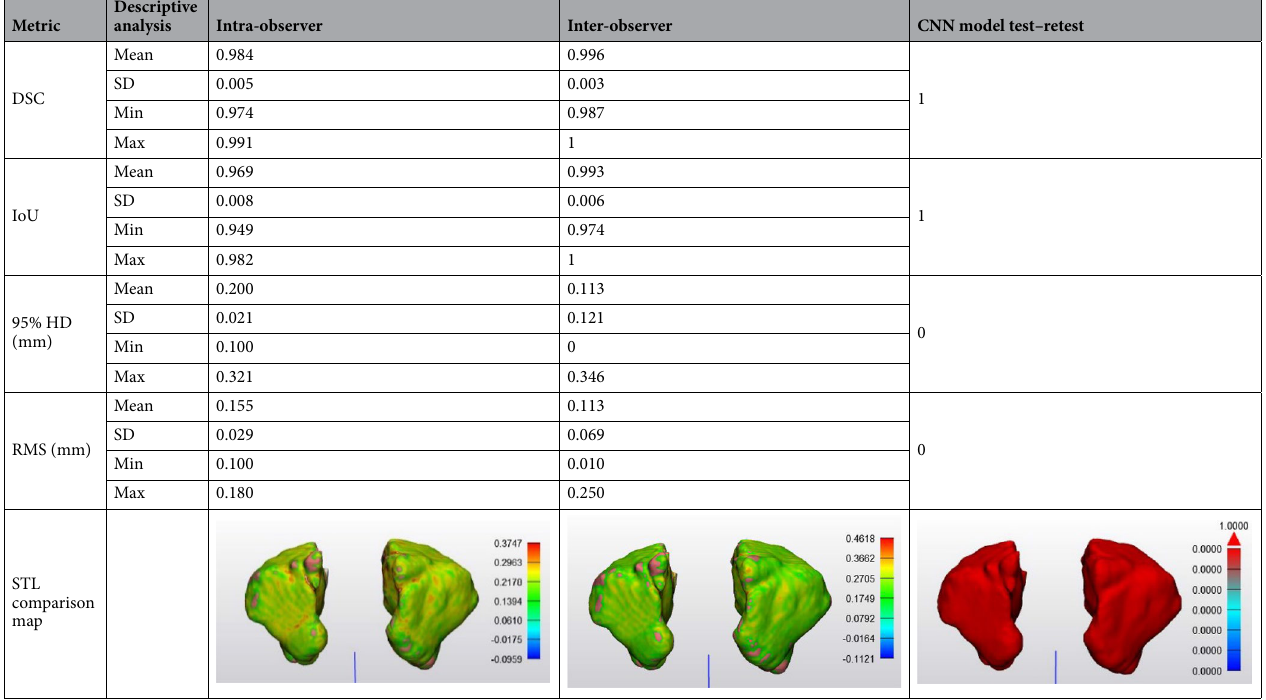
Table 4. Mean and standard deviation for reliability assessment. DSC dice similarity coefficient, IoU intersection over union, HD hausdorff distance, RMS root mean square, SD standard deviation, Min minimal value, Max maximal